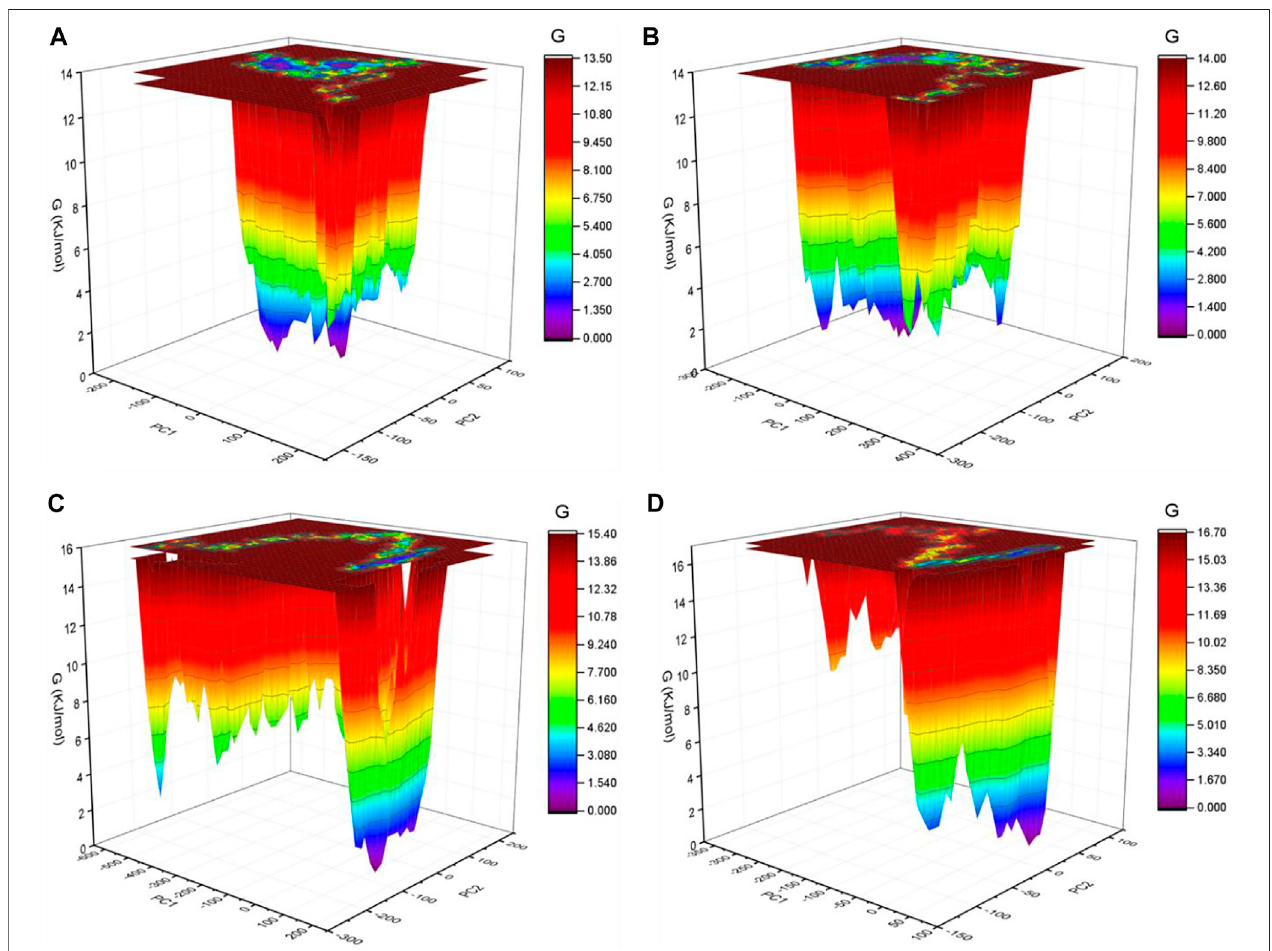
FIGURE 7 | GFE landscape. The GFE landscape plot achieved for SARS-CoV-2 spike protein at (A) 0 ° C, (B) 20 ° C, (C) 40 ° C, and (D) 60 ° C, respectively.